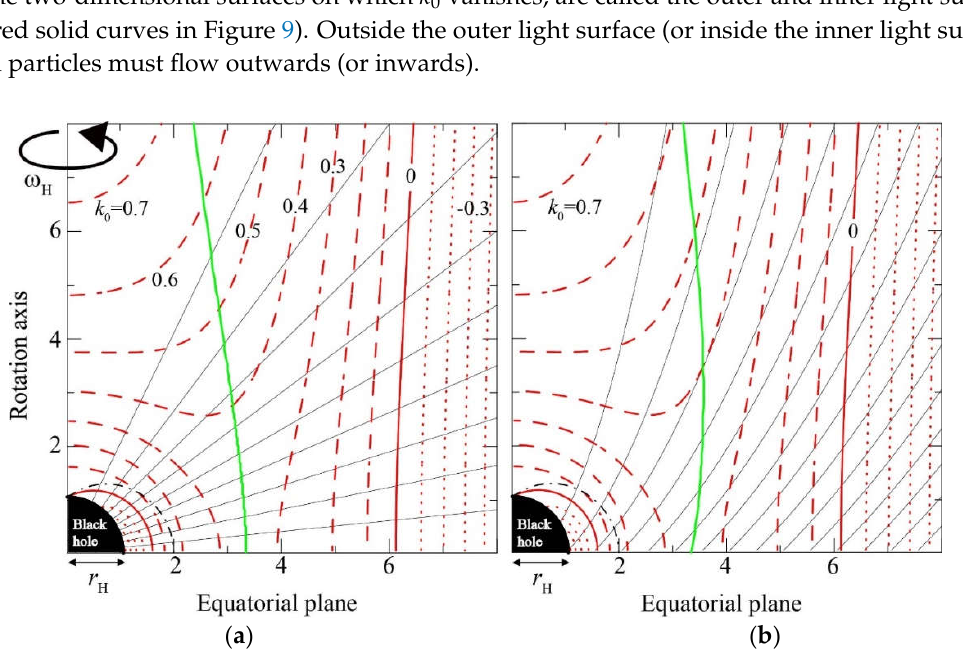
Figure 9. Distribution of the stagnation surface (thick green solid curve) on the poloidal plane. Similar to Figure 7, but equi- k 0 potential curves are depicted with the dashed curves (for positive values) and dotted ones (for negative values). The thick, red solid curves denote the outer and inner light surfaces where k 0 vanishes. ( a ) The case of a split-monopole magnetic field. ( b ) The case of a parabolic field. From [61].